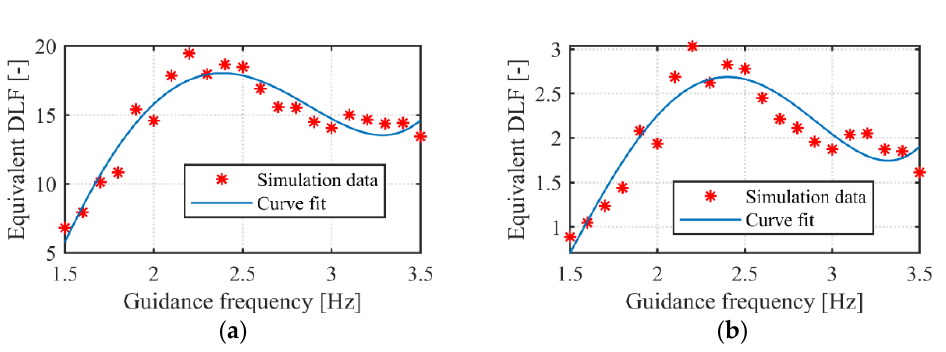
Figure 3. Modeling of the equivalent DLF for the standard working condition. ( a ) Equivalent DLF for the first harmonic, ( b ) Equivalent DLF for the second